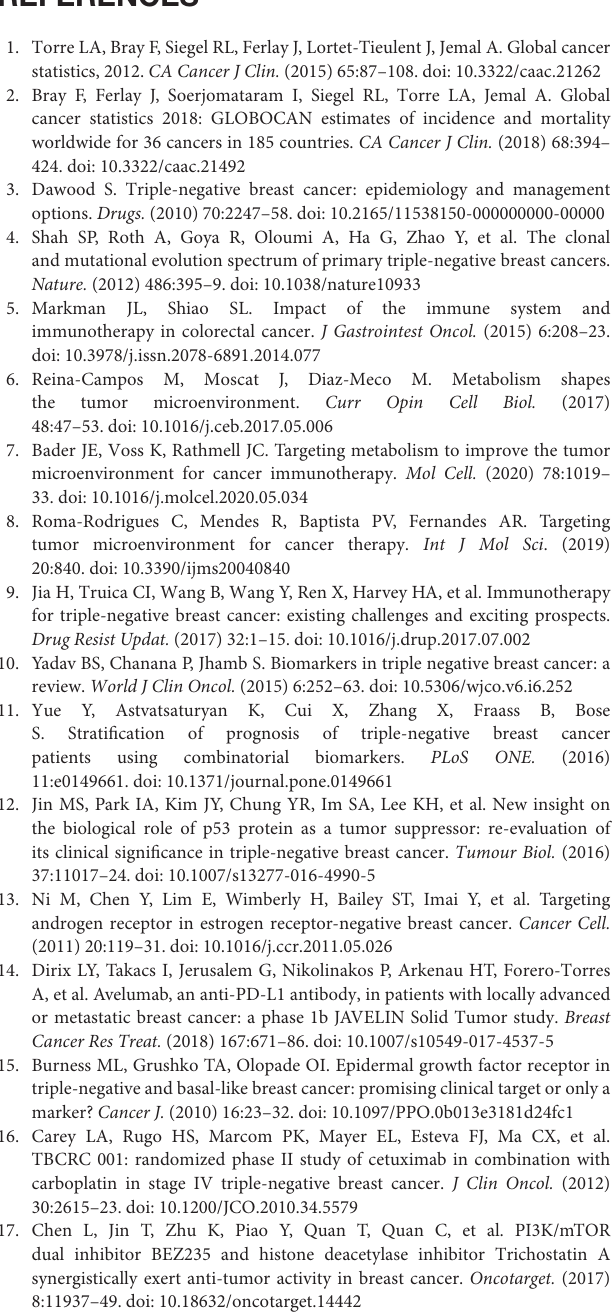
Supplementary Figure 2 | The survival status of immune subtypes. Supplementary Figure 3 | The expression of seven key genes in three subtypes in the RNASeq dataset. Kruskal-Wallis test was performed. ∗∗∗∗ P < 0.0001. Supplementary Figure 4 | The PPI results of five genes (CLCA2 and SPINK8 were not shown as no interaction networks were found). Supplementary Figure 5 | Four genes with survival differences.